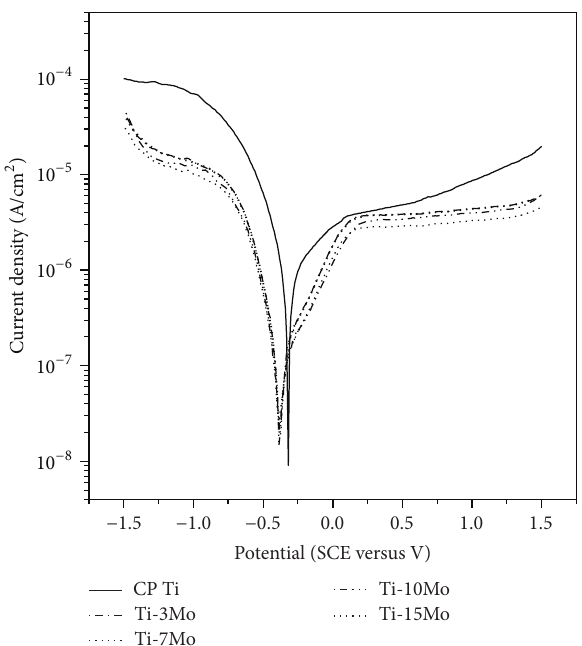
Figure 4: Potentiodynamic polarization curves of the Ti-Mo alloys in the SBF solution at 37 ∘ C.